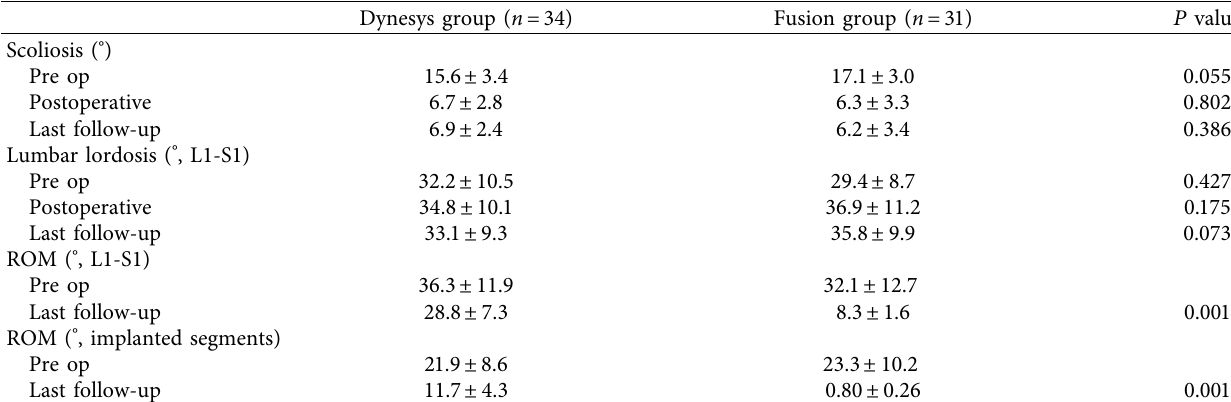
Table 3: Radiological